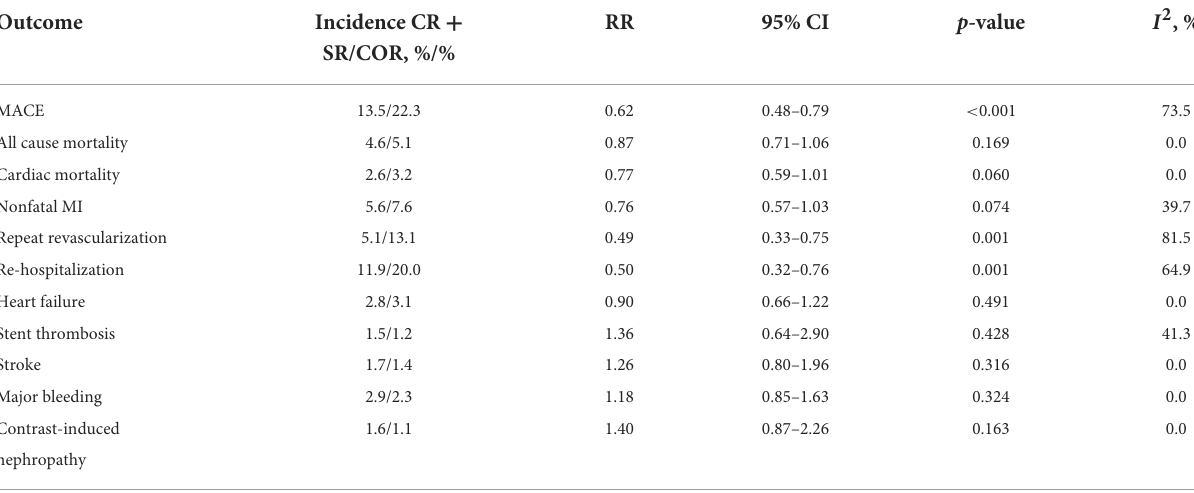
TABLE 2 Summary for the outcomes of the pairwise